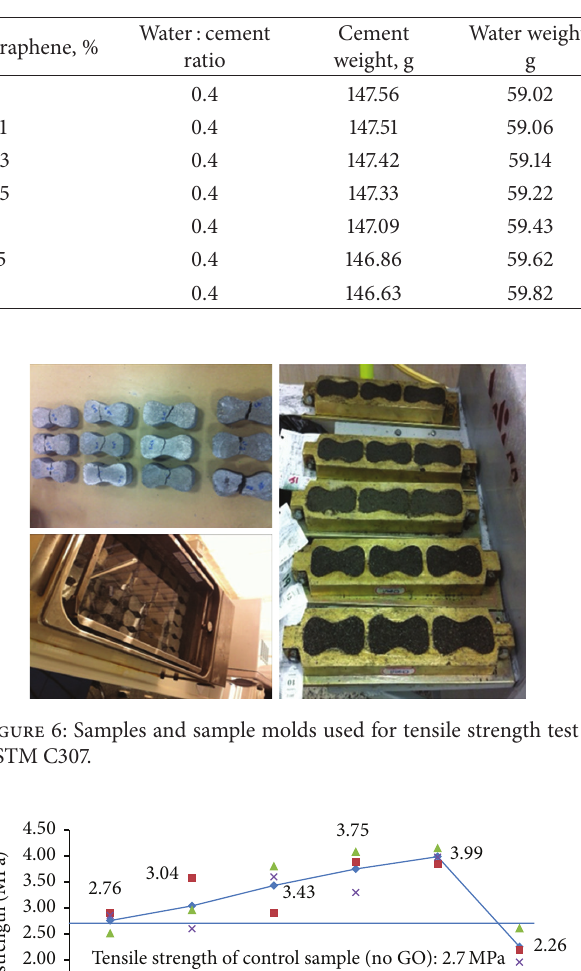
Table 4: Mixture proportions for the samples.